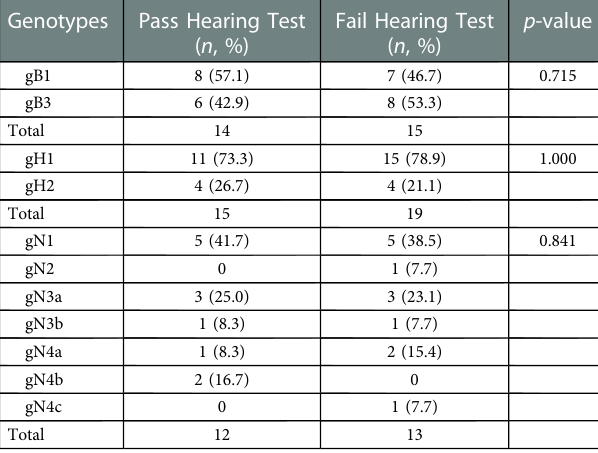
TABLE 2 Distributions of gB, gH and gN genotypes among symptomatic cCMV infected neonates with or without hearing loss. Genotypes